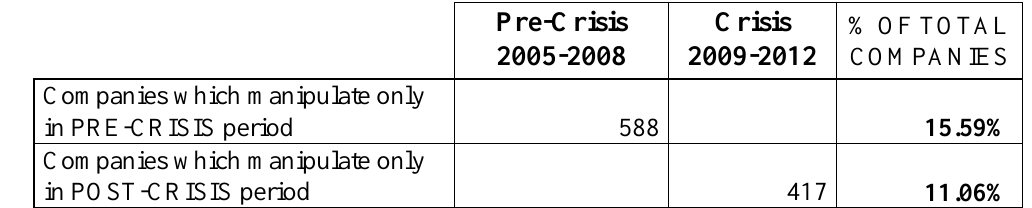
Table 4: Number of companies which changes probability (from high to low and vice-versa) from pre-crisis to crisis period